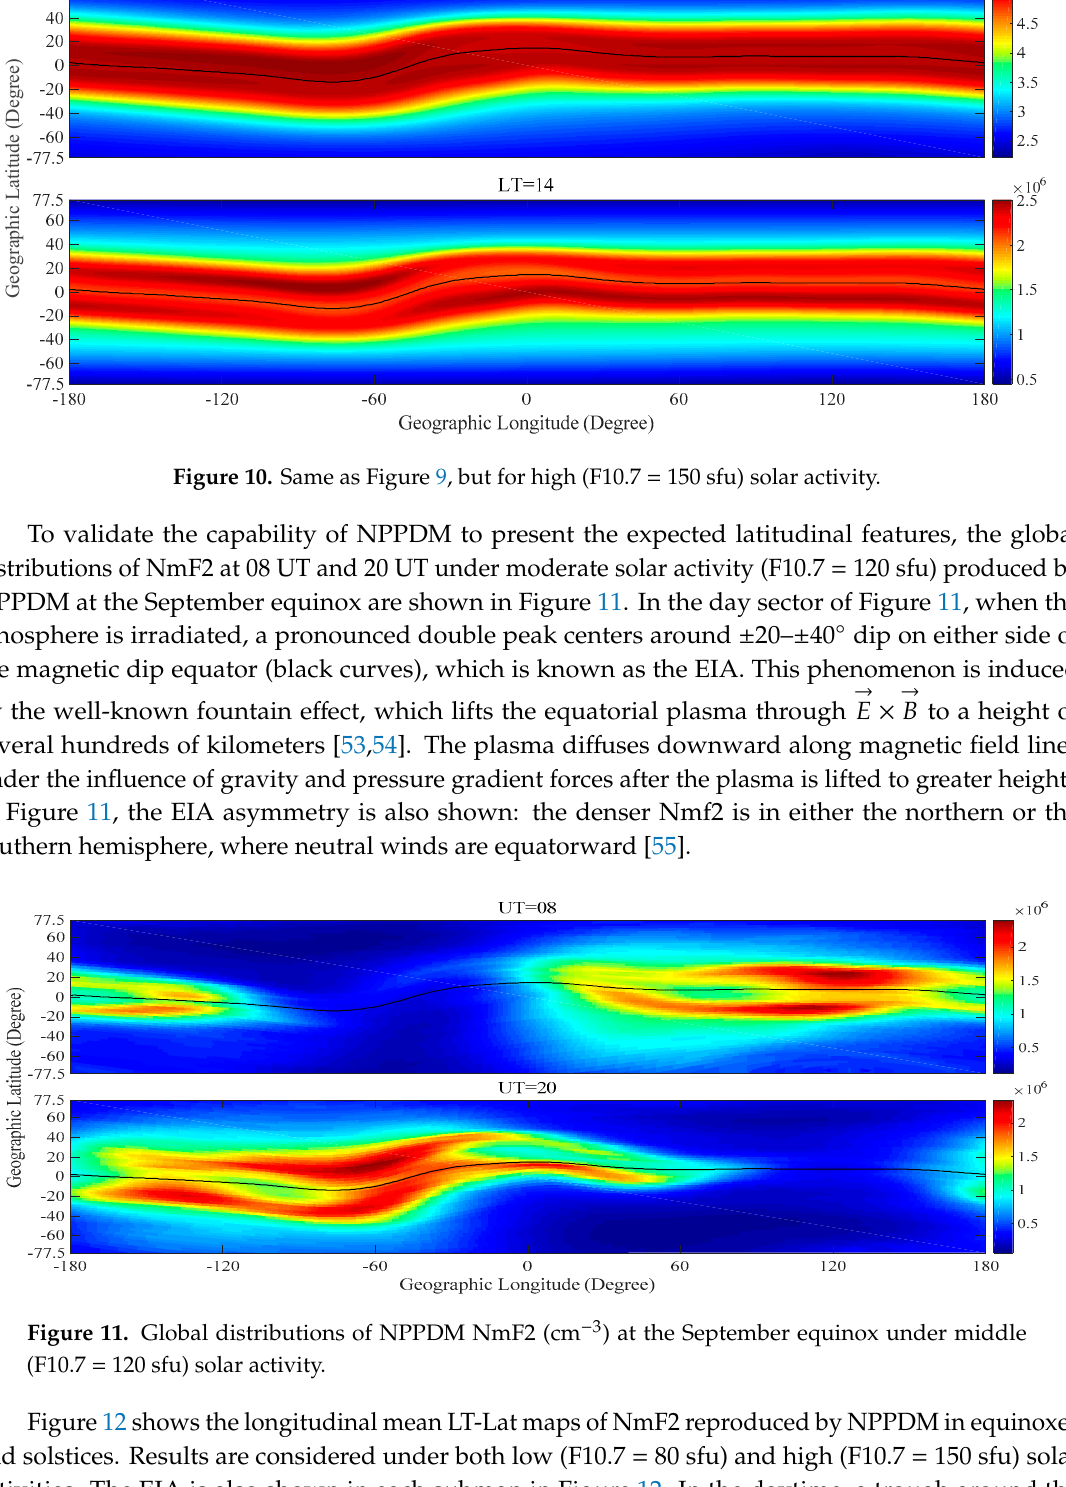
Figure 9. Global distribution of NPDM NmF2 ( solar activity.